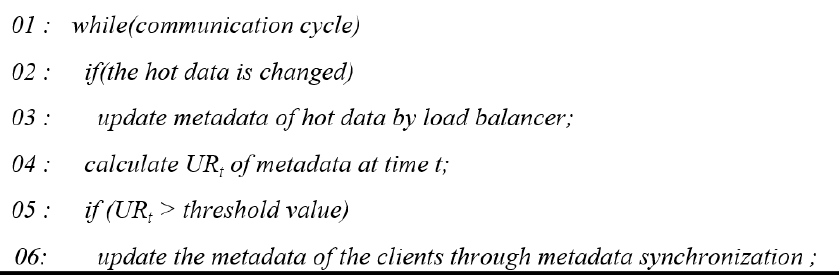
Figure 14. Client hot data metadata synchronization algorithm.